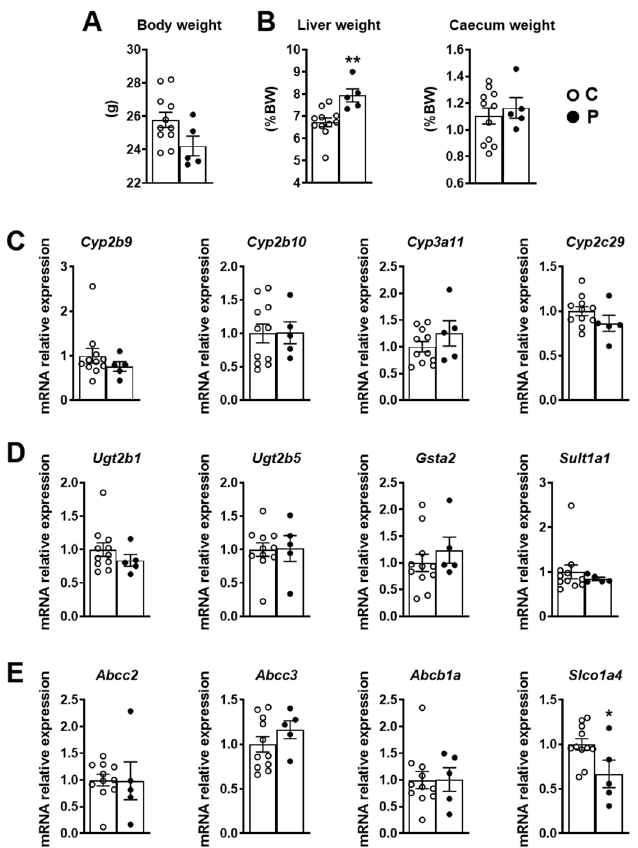
Figure 2. Body ( A ) liver and caecum weight ( B ) in female F0 mice at weaning. Hepatic mRNA rela- tive expression of genes involved in phase I xenobiotic metabolism enzymes ( C ), phase II xenobiotic metabolism enzymes ( D ) and drug transporters ( E ) in F0 female mice upon dietary exposure to pesticides during gestation and lactation periods. Gene expression was assayed by RT-qPCR in liver samples of 5 pesticide-exposed and 11 unexposed F0 female mice. Data are presented as mean ± SEM. * p < 0.05 for P vs. C; ** p < 0.005 for P vs. C.